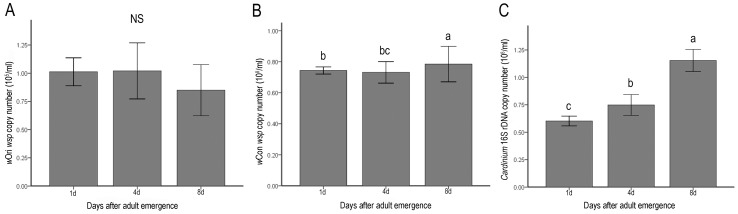
Mean densities of wOri (A), wCon (B) and Cardinium (C) during aging of multiple-infected males in T. phaselus population.Copy numbers per ml were determined by quantitative PCR using the wOri wsp gene, wCon wsp gene and 16S rDNA gene (error bars represent 95% bootstrap confidence intervals, n = 8 per each column). a, b and c represent statistic groups (Tukey-HSD test, p<0.05); NS, not significant at the 5% level.